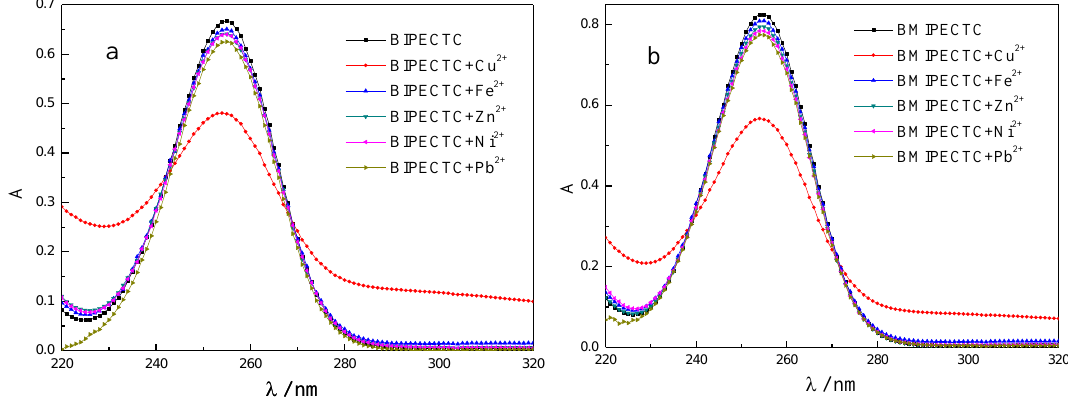
Figure 10. UV spectra of collectors and their complexes with Cu 2+ , Fe 2+ , Ni 2+ , Zn 2+ or Pb 2+ ions: ( a ) BIPECTC; and ( b ) BMIPECTC.